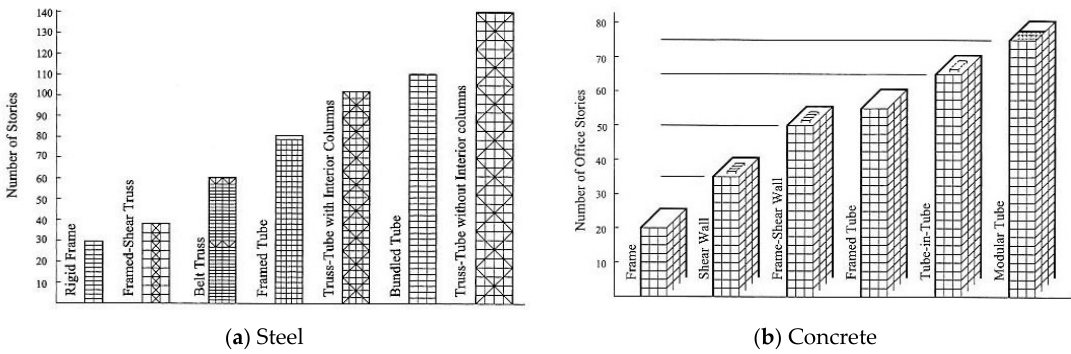
Figure 2. Classification of tall building structural systems by Fazlur Khan [5,11,12].